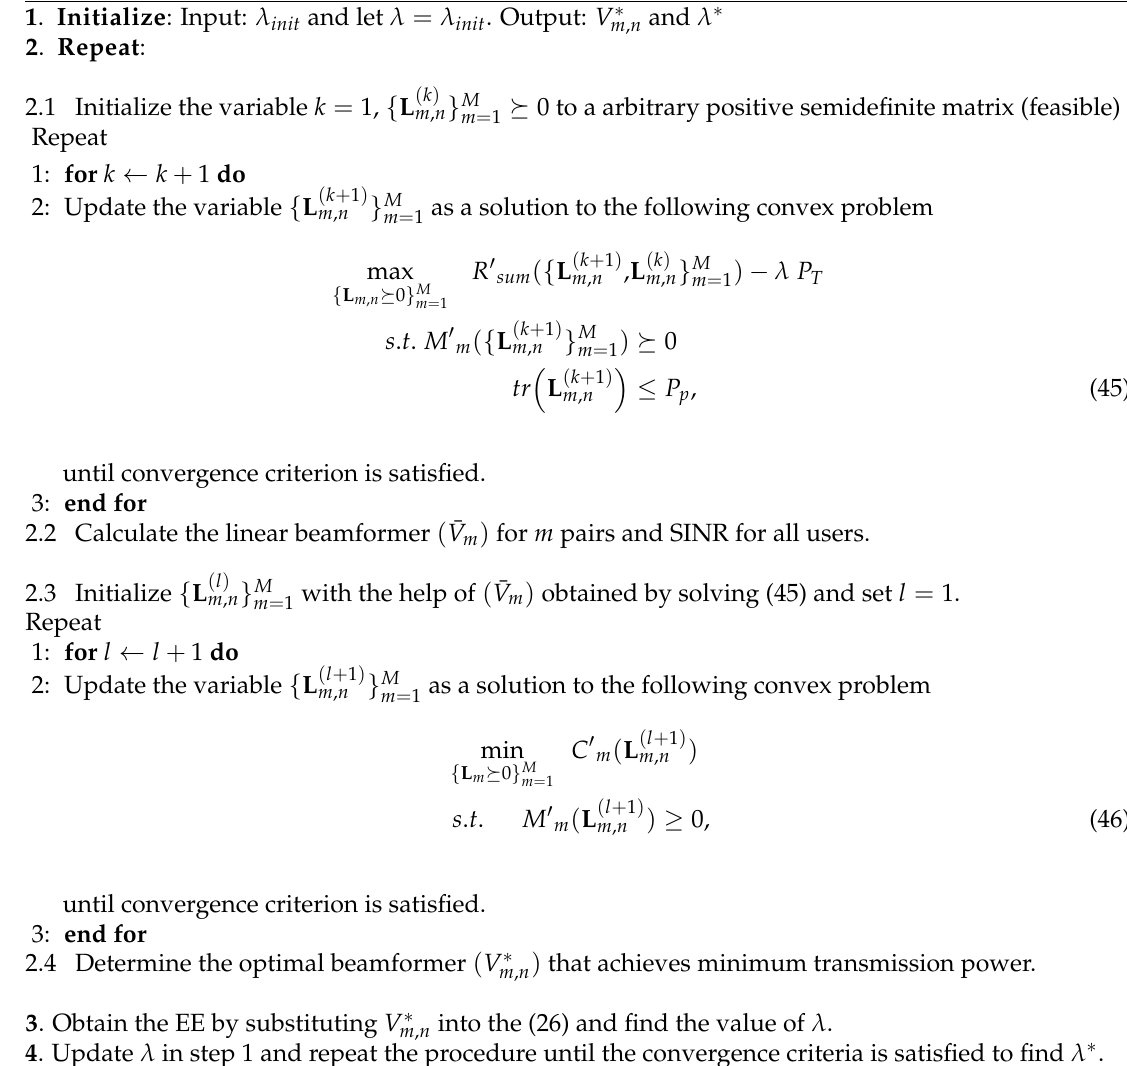
Algorithm 2 Proposed JRBEE maximization